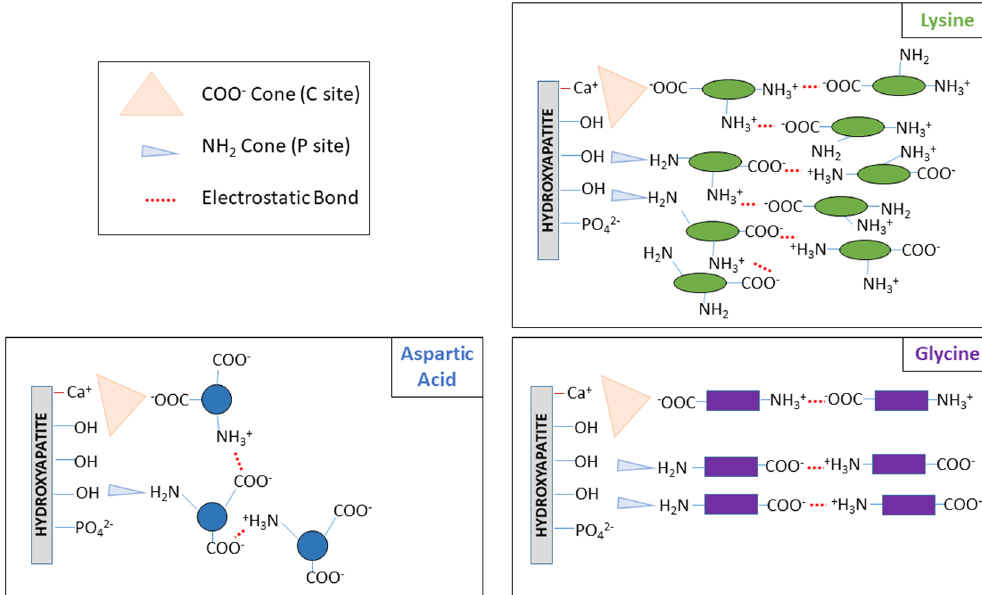
Figure 7. A proposed schematic for the dominant mode of adsorption of the different amino acids at the ns- nHA surface. Both amine and carboxyl functional groups contributed to the attachment of the amino acids to the ns-nHA surface. This schematic generally encompasses each reaction condition, owing to little dependence observed on reaction condition (i.e. pH or pre-saturation with calcium); however, it is important to recognize that the fraction of amine groups which are ionized will change in the schematic as pH changes. Overall, the ease of approach towards the negatively charged ns-nHA surface is greatest for Lysine and Glycine, and more challenging for the negatively charged Aspartic acid. As a result, the attachment of Aspartic acid to the ns-nHA surface is more limited compared to the other two amino